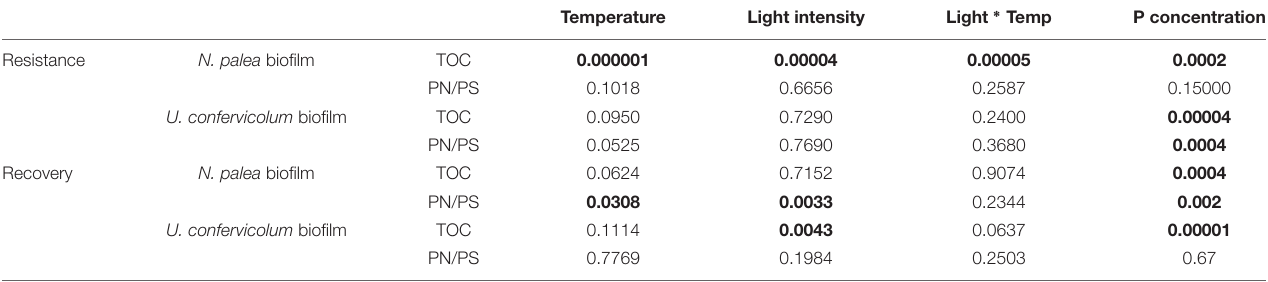
TABLE 2 | P -values for two-way and one-way ANOVAS to test the effect of environmental conditions on the resistance and recovery of biofilm EPS quantity and quality.